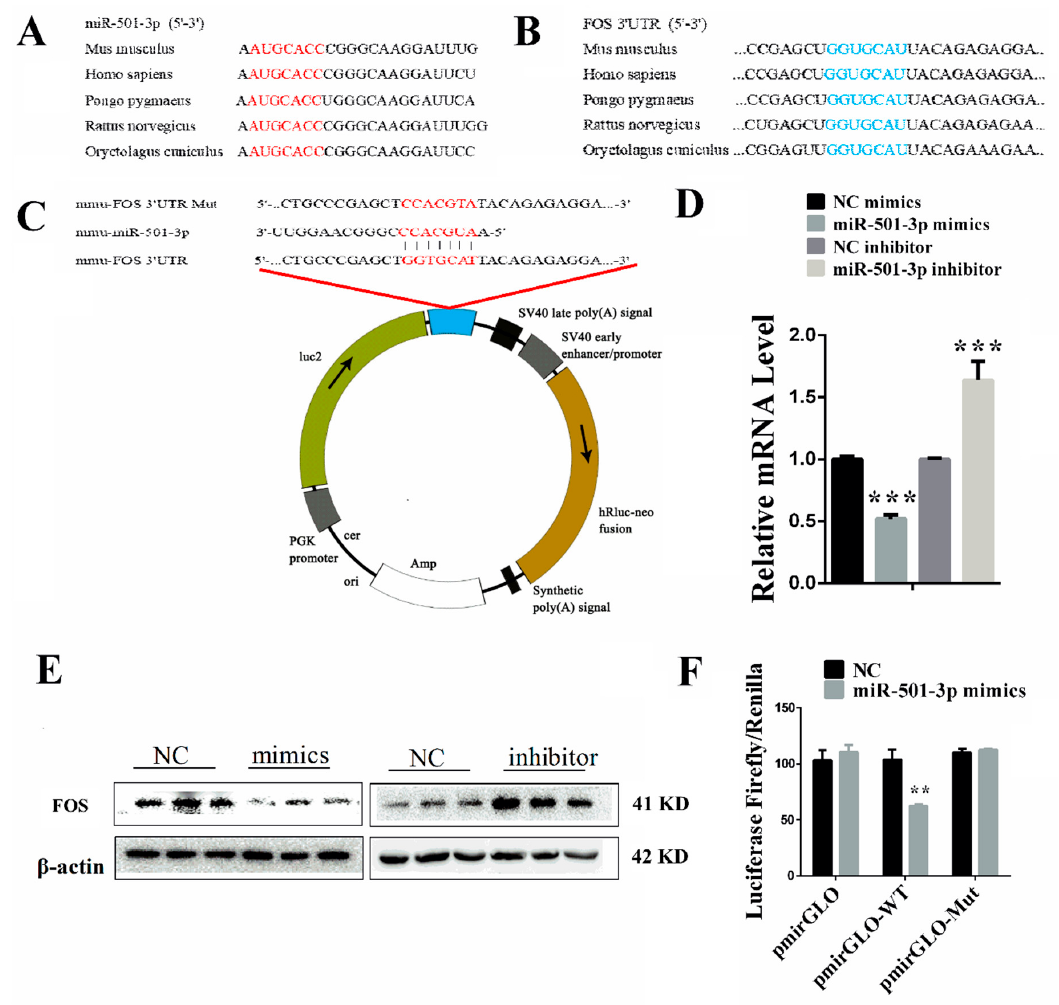
Figure 4. FOS is a direct target gene of miR-501-3p. ( A ) The sequence of mature miR-501-3p of different species. ( B ) The alignment result of FOS 3’UTR sequence from different species. Red: the complementary sequence of the FOS 3 (cid:48) UTR. ( C ) The complementary pairing of